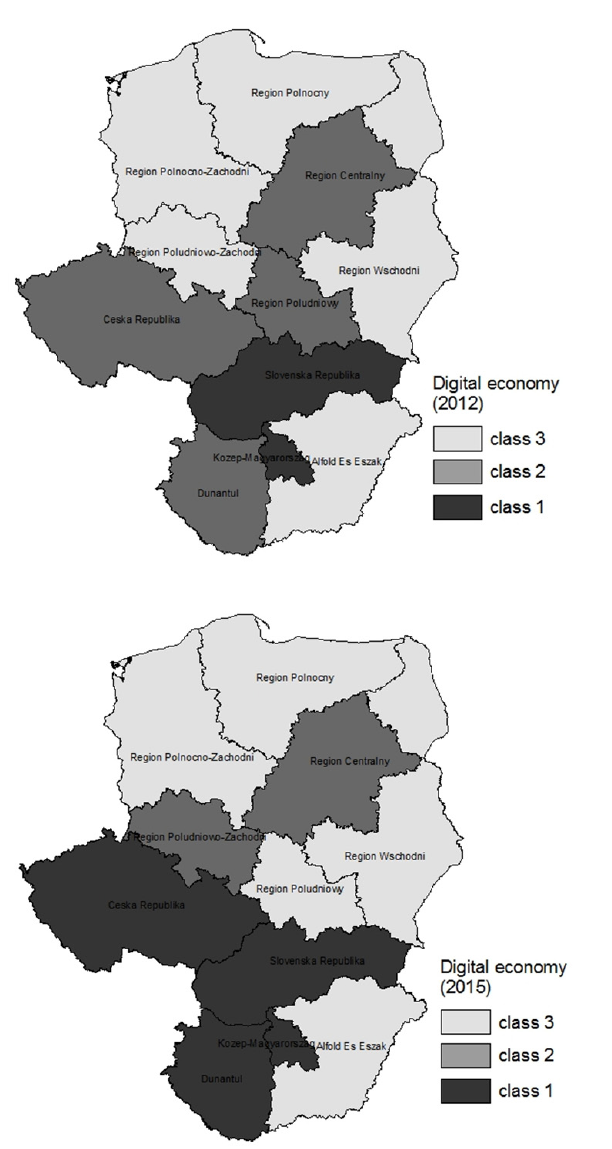
Fig. 1 – The level of digital economy in regions for Visegrad countries in the year 2012 and 2015. Source: own